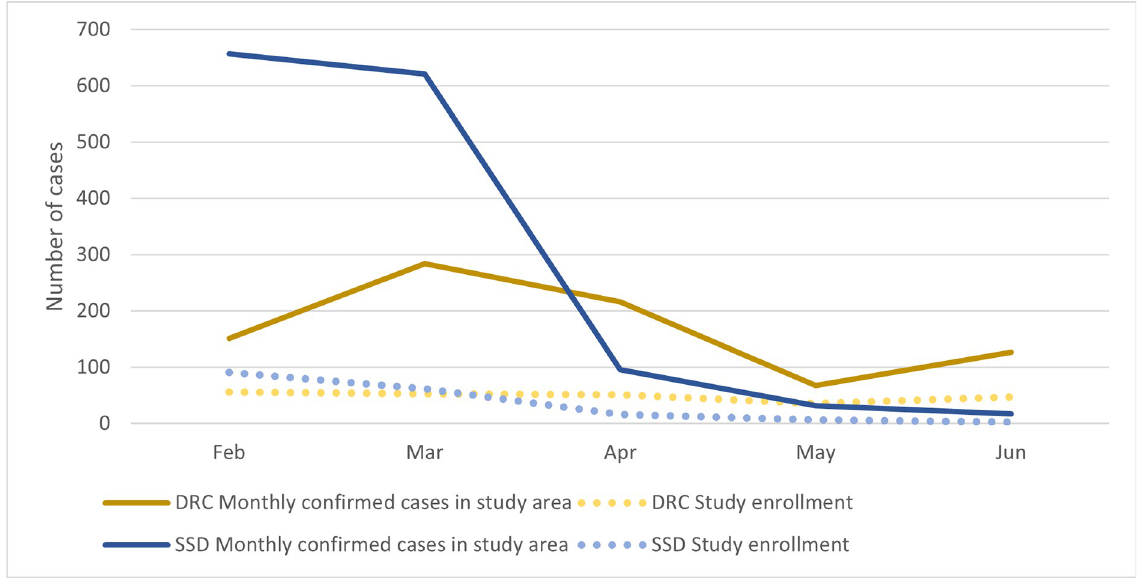
Fig 2. Monthly trends in new cases reported in study area compared to participant enrollment � in SSD, December 2020-June 2021. SSD = South Sudan � Systematic tracking of eligible cases in SSD through laboratory results began Feb . 2021 . Data prior to this period is not reported in this figure